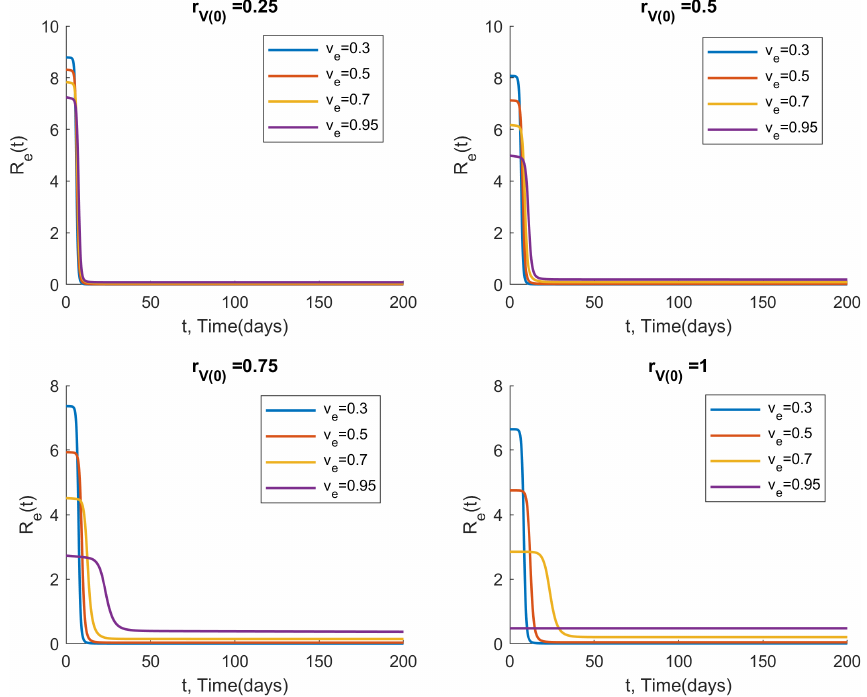
Figure 7. Effective reproduction number R e ( t ) with respect to time t for a simulated Omicron outbreak, with initial vaccination coverage ratio r V ( 0 ) , vaccine efficacy v e , a vaccination rate of k = 0.002, and no NPIs ( c = 0). Note that the lowest vaccine efficiencies result in the lowest R e ( t ) for large t , as the supply of susceptible individuals becomes